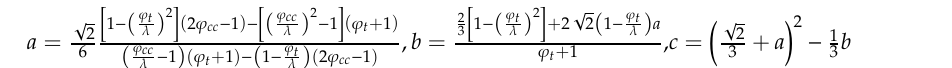
π ; ( c ) plane 3 ; ( c ) plane (cid:2871)